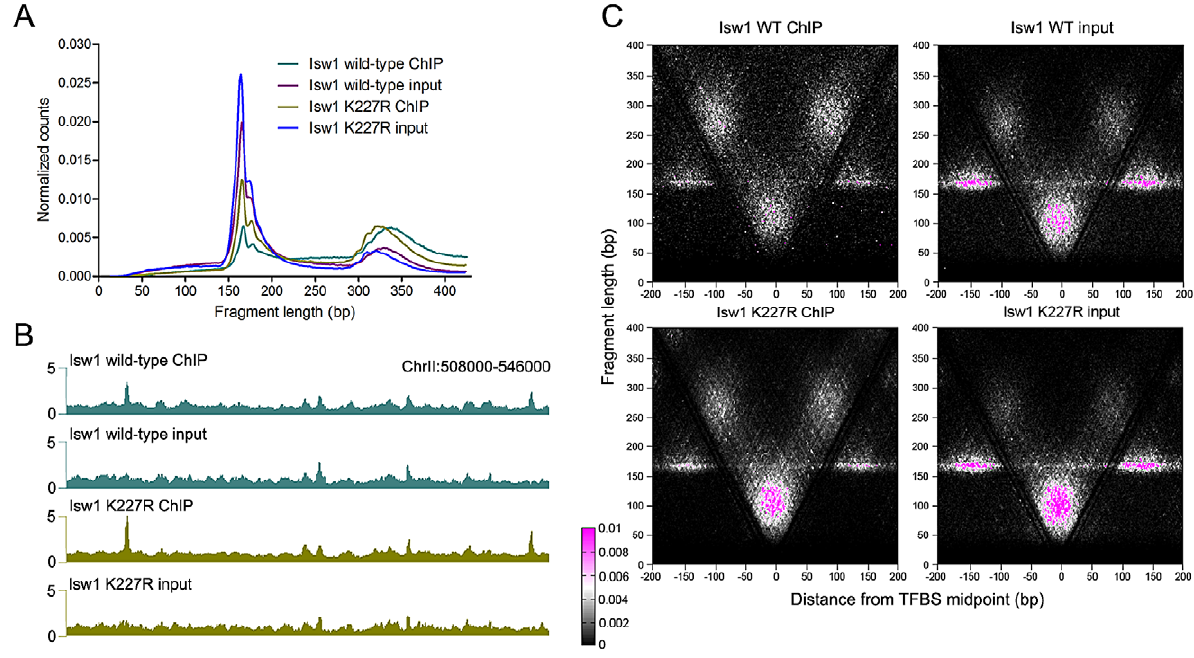
Figure 5. ISWI and CHD remodeler association with TFBSs is ATP-independent. (A) Size distributions of mapped paired-end 2.5 9 MNase- digested wild-type and catalytically inactive K227R Isw1 ChIP and input fragments. Similar profiles were seen for Isw2 K215R and Chd1 K407R (Figure S4). (B) Profiles of wild-type and K227R Isw1 binding along a representative segment of the genome. (C) V-plots of wild-type and K227R Isw1 ChIP and soluble input chromatin at binding sites for the Reb1 TF, determined by ChIP-exo, after 2.5 9 MNase digestion. The overall fragment size in the Isw1 K227R ChIP and input samples is slightly reduced when compared to wild-type, indicative of technical variation in MNase digestion. Similar results were seen for K227R Isw1 and catalytically inactive Isw2 (K215R) and Chd1 (K407R) at Abf1 and other TFBSs (Figures S4 and S6).